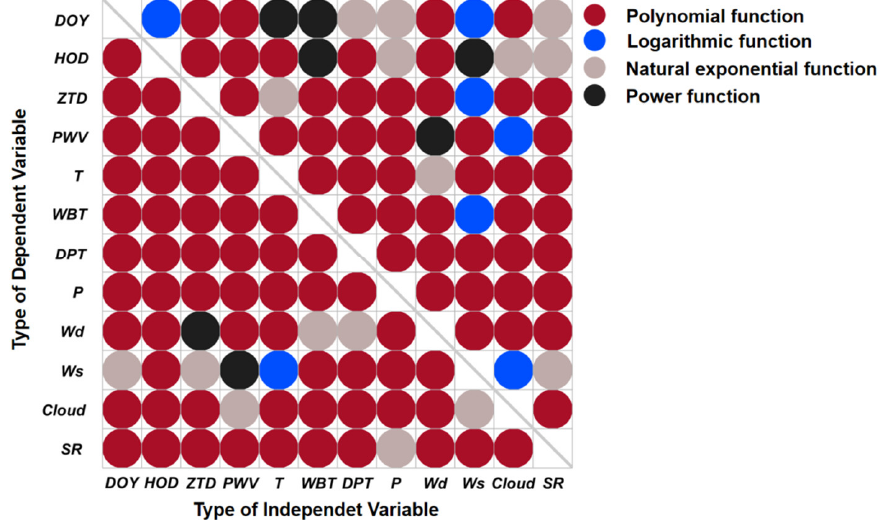
Figure 3. Selection of optimal nonlinear function for fitting the relationship between each two types of variables.